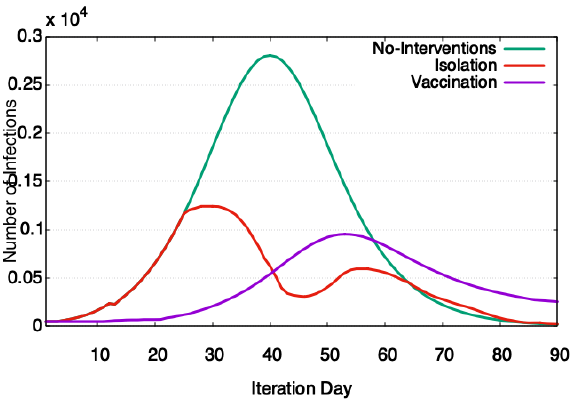
Figure 9. Effect of interventions on the spread of disease. In no intervention case, the attack rate is 35%. In the isolation case, the attack rate is 18%. In the vaccination case, the attack rate is